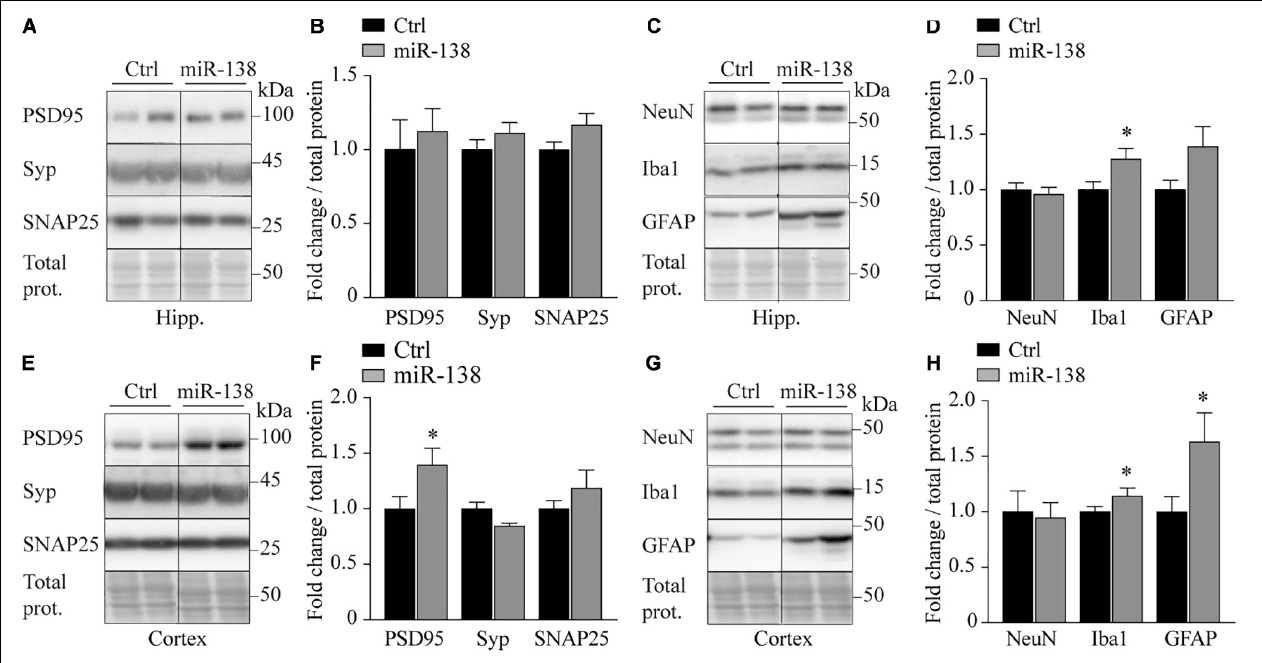
FIGURE 5 | Abnormal brain integrity markers in 138 mice. (A) Representative western blot of endogenous (B) PSD95, synaptophysin (Syp), and SNAP25 quantification in hippocampus (Hipp.) of miR-138 mice compared to Ctrl mice, at 4 months of age. (C) Representative Western blot of endogenous (D) NeuN, Iba1, and GFAP quantification in hippocampus (Hipp.) of miR-138 mice compared to Ctrl mice. (E) Representative western blot of endogenous (F) PSD95, synaptophysin (Syp), and SNAP25 quantification in frontal cortex (Cortex) of miR-138 mice compared to Ctrl mice. (G) Representative Western blot of endogenous (H) NeuN, Iba1 and GFAP quantification in frontal cortex (Cortex) of miR-138 mice compared to Ctrl mice. Bands were normalized to total proteins. All analyses were performed on 30 mice in total ( n = 13 males and n = 17 females). Data are presented as ± SEM: * P < 0.05, ** P < 0.01, *** P < 0.001 (unpaired student t